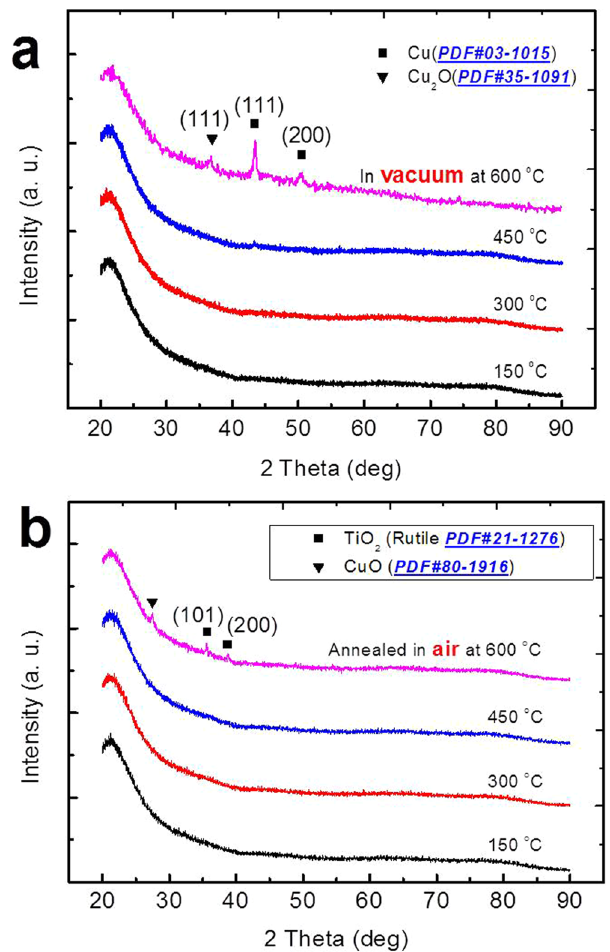
Figure 2. The XRD patterns of the samples with different Temperature in the range 150 to 600 °C ( a ) Vacuumed annealing ( b ) Air